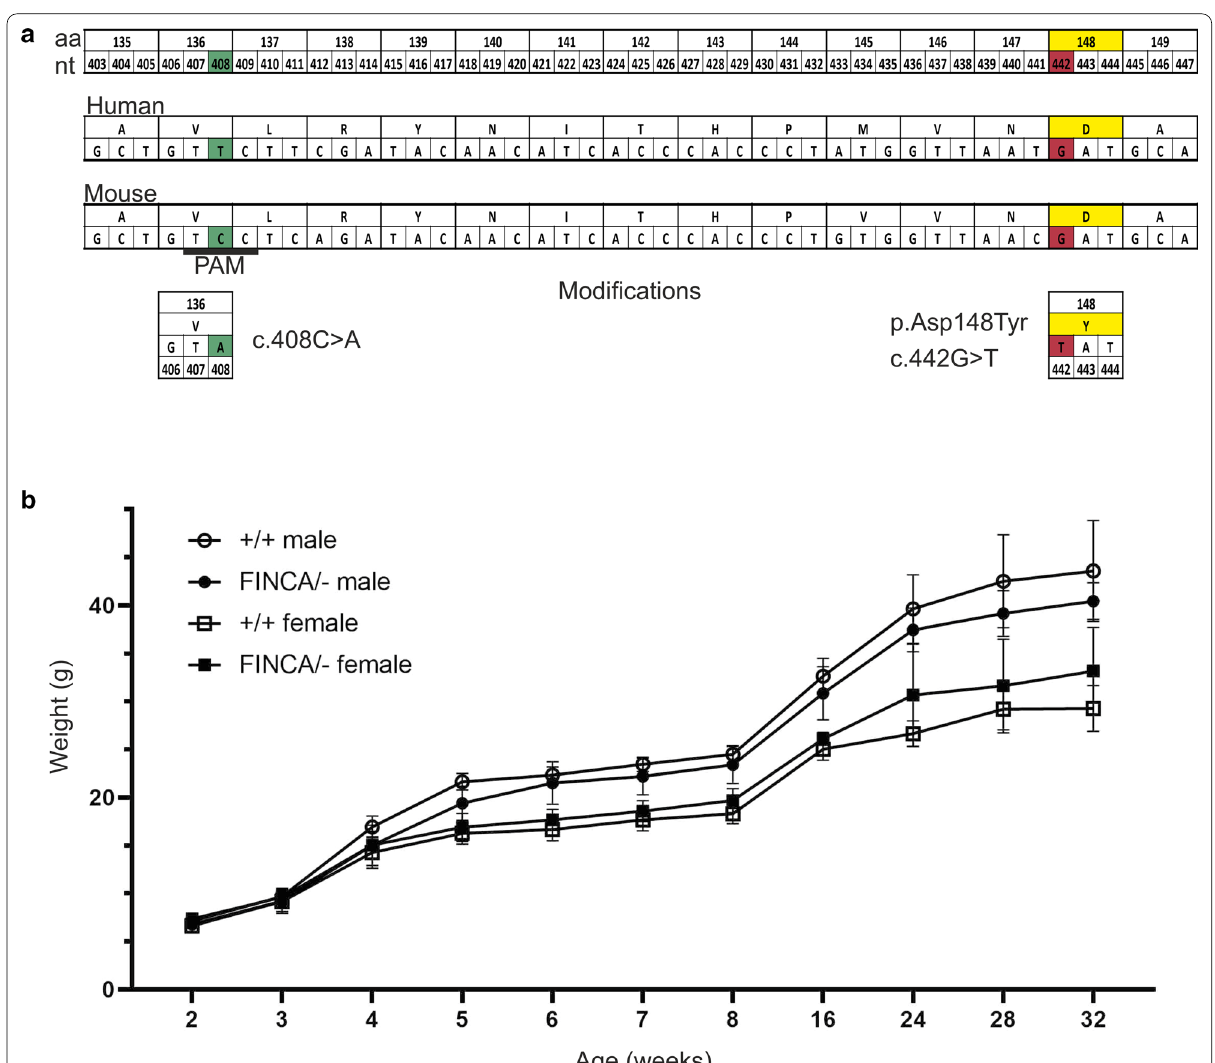
Fig. 1 Schematic of the generated FINCA allele and body weight curve of Nhlrc2 FINCA/ − and Nhlrc2 + / + mice. a Modified region of mouse and human amino acid (aa) and nucleotide sequence (nt) of the modified region. Silent mutation leading to removal of the PAM site and resulting in the addition of a TatI restriction site (green) was included in the ssODN. FINCA variant c.442G > T (red) and amino acid substitution p.Asp148Tyr (yellow) are shown. b Body weight curve showing no significant difference in weight gain for either sex between Nhlrc2 FINCA/ − and Nhlrc2 + / + mice during the 32- week observation period (two-way ANOVA). Nhlrc2 FINCA/ − male (N (N 5). Mean and standard deviation (SD) =